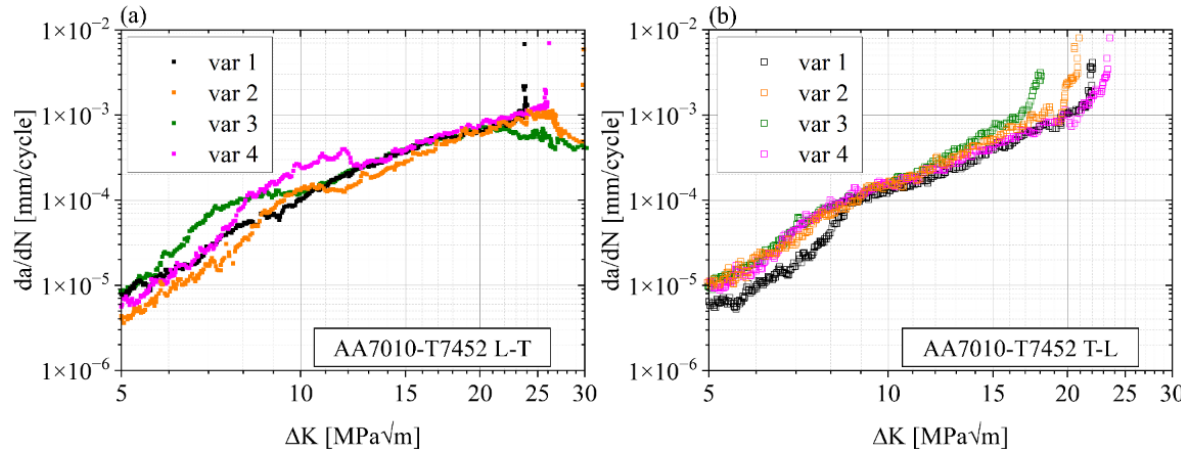
Figure 6. AA7010-T7452 crack growth curves da/dN- Δ K for L-T ( a ) and T-L ( b ) orientations.